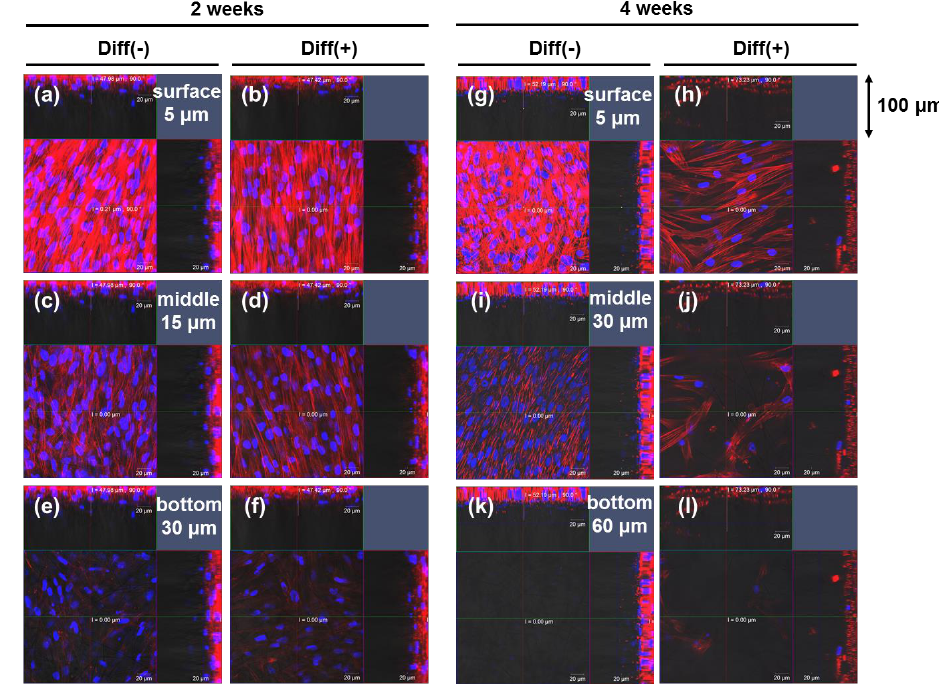
Figure 1. Confocal-laser scanning microscopic (CLSM) images showing proliferation and morphology of mesenchymal stem cells (MSCs) cultured in normal medium (Diff (−)) and chondrogenic differentiation medium (Diff (+)) on three-dimensional (3D) silica nonwoven fabrics for 2 weeks ( a – f ) and 4 weeks ( g – l ). In each case, single optical slices near the surface (5.0 μm: a, b, g, h), in the middle (15 μm: c, d, 30 μm: i, j), and near the bottom (30 μm: e, f, 60 μm: k, l) of the silica fabrics are shown. Cellular nuclei and skeletons were stained with Hoechst 33342 (blue) and Alexa Fluor 594 phalloidin (red), respectively. Scale bars: 20